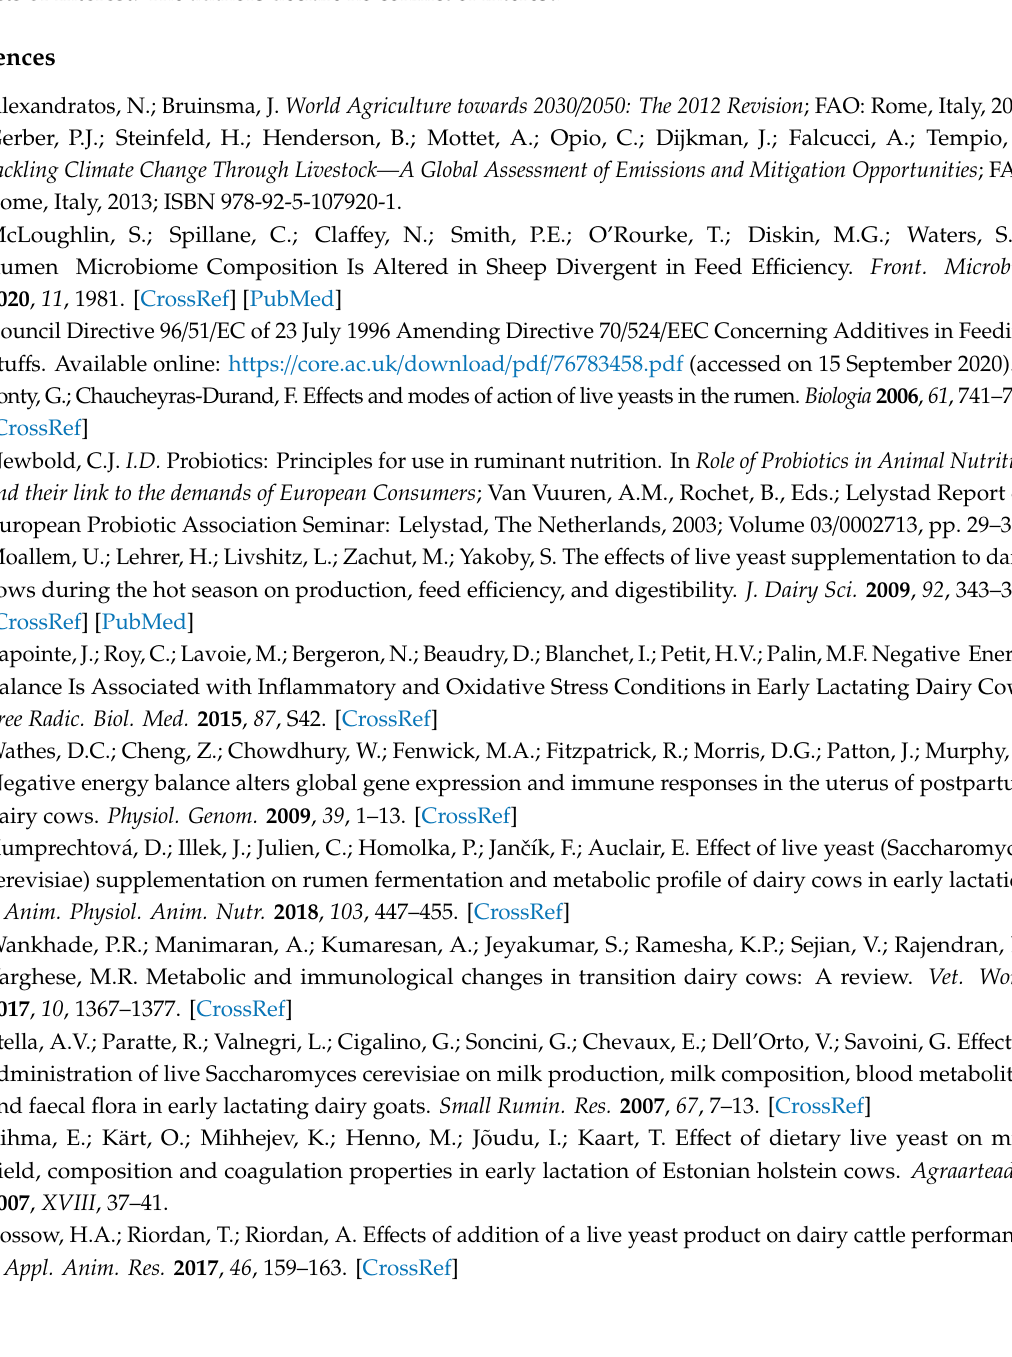
Table S6. Milk yield and milk chemical composition of ewes fed the Control and ActiSaf diets in the six sampling times; Table S7. Sequences of primers for target genes used in real-time qPCR; Figure S1. Graphical representation of milk chemical composition of the Control and ActiSaf